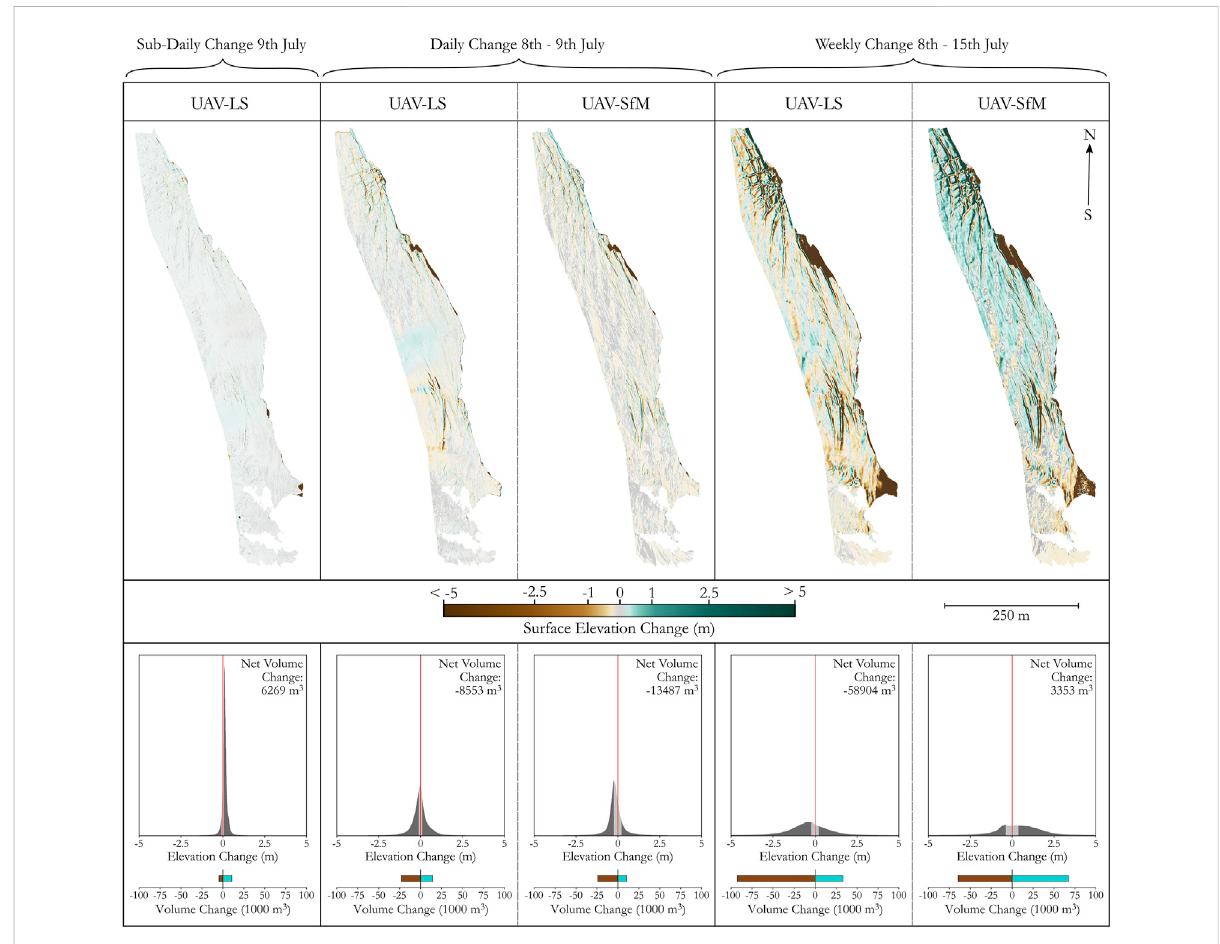
FIGURE 7 Results of the surface elevation change analysis, carried out using DEM differencing for different time periods for both the UAV-LS and UAV- SfM-derived DEMs. The upper panels show the spatial variation in elevation differences across the glacier surface. Areas in grey represent change below the NMAD analysis for each comparison outlined in Figure 4 and Figure 6. These grey areas are highlighted within the histogram panels, showing the number of pixels where change is less than the precision of the sensor. Total volume change for each time period is also shown next to the distribution of change, as well as the total loss and gain respectively for each method over each time period. This net volume change excludes any change below the limit of detection between each survey pair, i.e. excluding change within grey